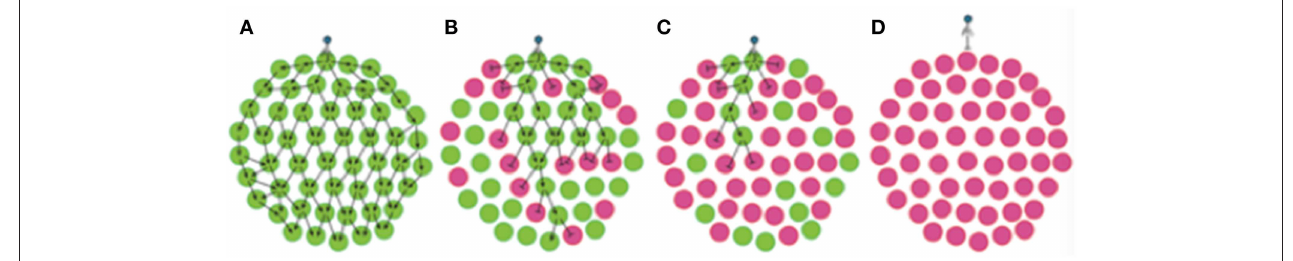
FIGURE 7 | Phase variation of phage resistance genes generates “bacterial herd-immunity” in bacterial meta-populations. Phase variation of a phage-receptor can generate heterogeneous bacterial meta-populations containing a mix of sub-populations that are either susceptible or resistant to phage infection. High proportions of resistant sub-populations can both hinder phage spread and protect susceptible populations from phage attack. In this figure, we show the routes of phage dissemination through four different bacterial meta-populations. Green circles represent phage-susceptible populations while pink circles are phage-resistant populations i.e., lic2A ON and OFF populations in our experimental system. Lines with arrowheads show infection events leading to successful phage replication, while lines with bar-heads represent directions where phage-resistant populations act as a barricade blocking phage spread. Regions free of arrows are those free of phage. Phage spread is shown for: (A) a 100% phage-susceptible ( lic2A ON) sub-population; (B) 66% phage-susceptible ( lic2A ON) sub-populations; (C) 66% phage-resistant ( lic2A OFF) sub-populations; and (D) 100% phage-resistant ( lic2A OFF)